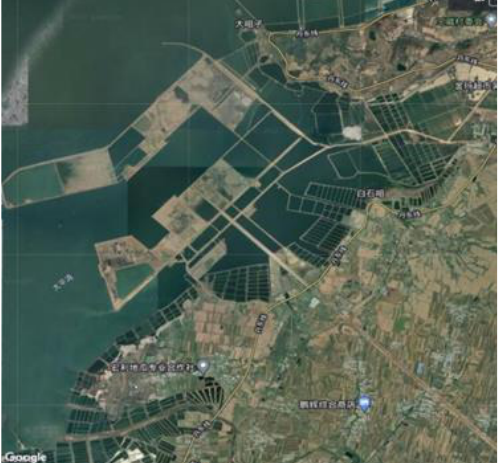
Figure 2. Construction progress of Taipingwan port area. Table 1. Basic physical and mechanical parameters of the SFS and the SC.